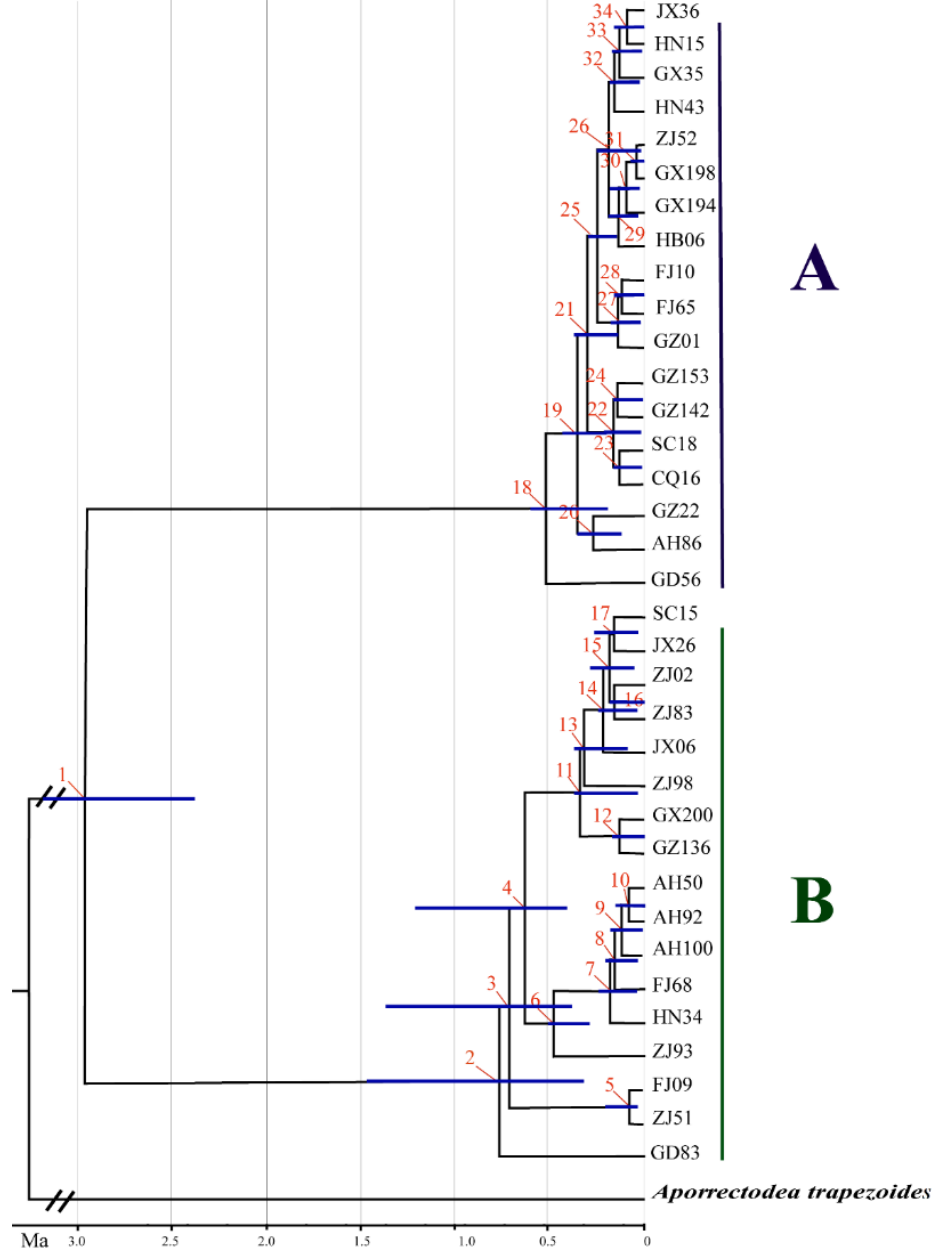
Figure 4. Divergence time estimate for A. triastriatus using a combined COI, COII, ATP8, ND6, 12S rRNA, 16S rRNA and NDI database based on a relaxed molecular clock (uncorrected lognormal). Details of numbers in each node are shown in Table 4. Table 4. Divergence times of A. triastriatus , estimated by the Bayesian method.